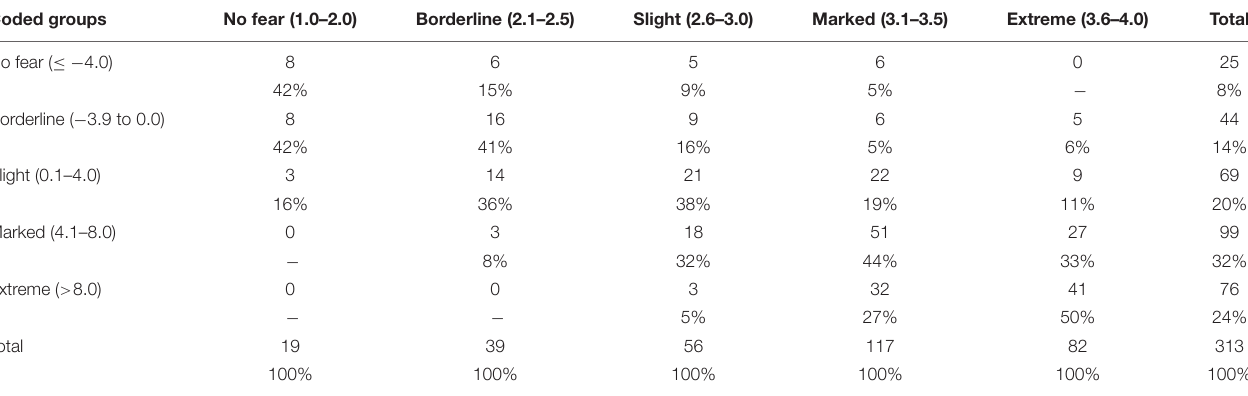
TABLE 7 | Crosstab of GELOPH<15> and Picture-Geloph < 9 > data, segmented into no fear, borderline, slight, marked, and extreme fear of being laughed at (Samples 1–3 combined). Coded